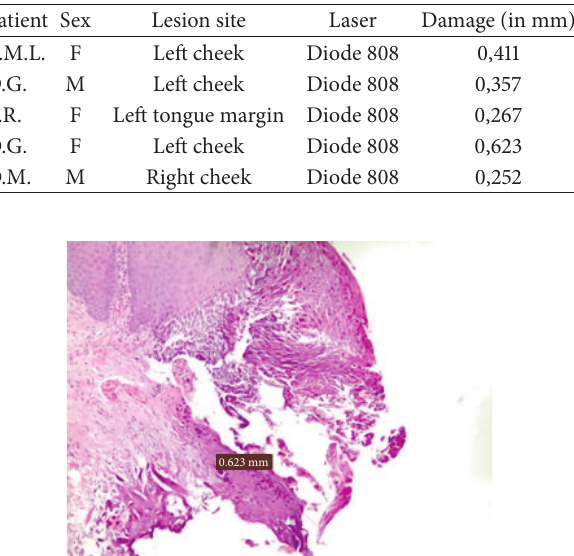
Table 1: Mucocele biopsies.